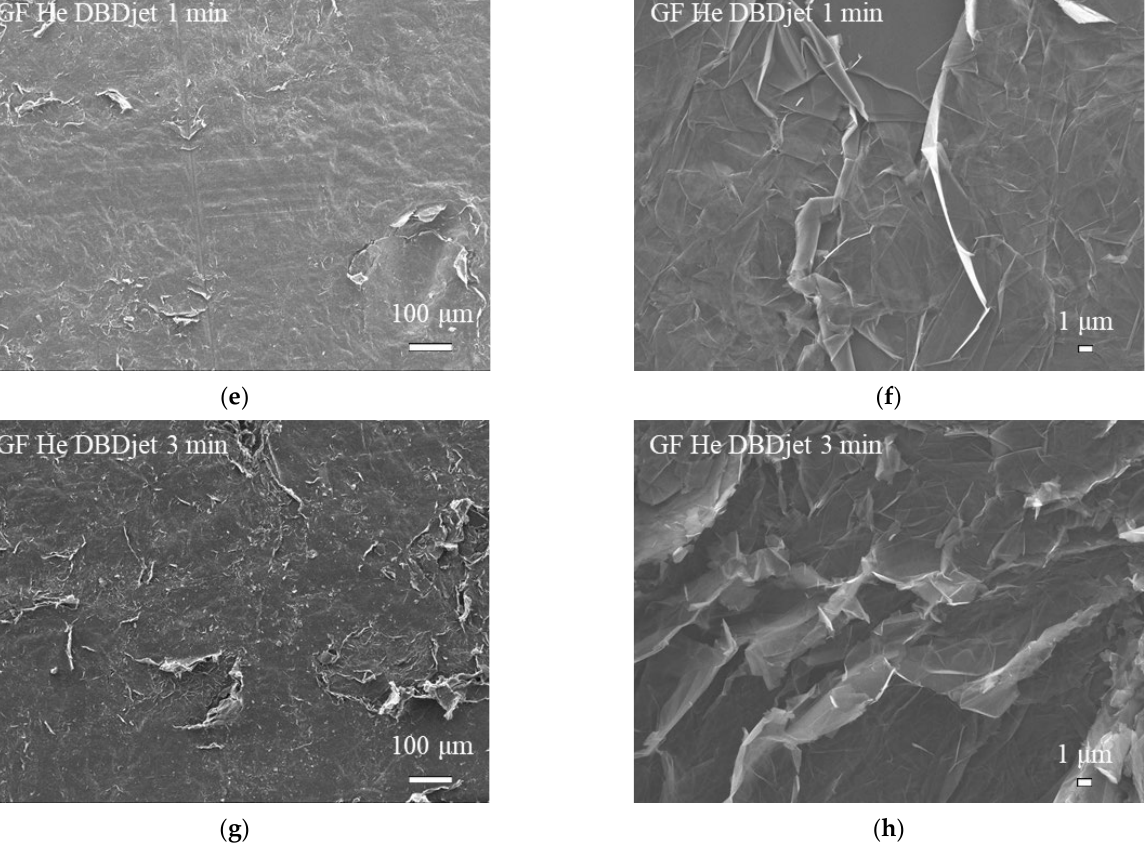
Figure 3. Top-view SEM images of graphite foil (GF) ( a , b ) without and ( c – h ) with He DBD jet treatment for ( c , d ) 30 s, ( e , f ) 1 min and ( g , h ) 3 min.